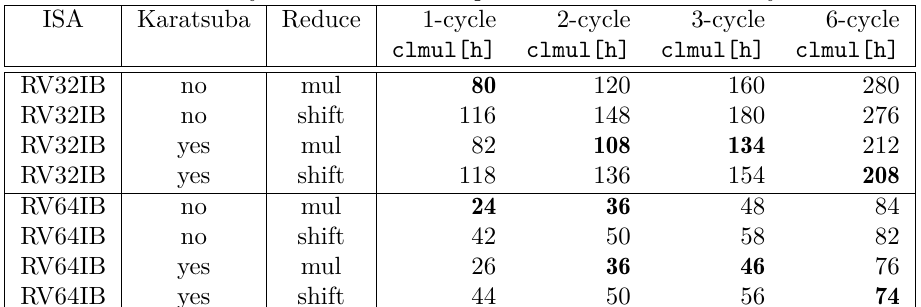
as used by GHASH . 2 128